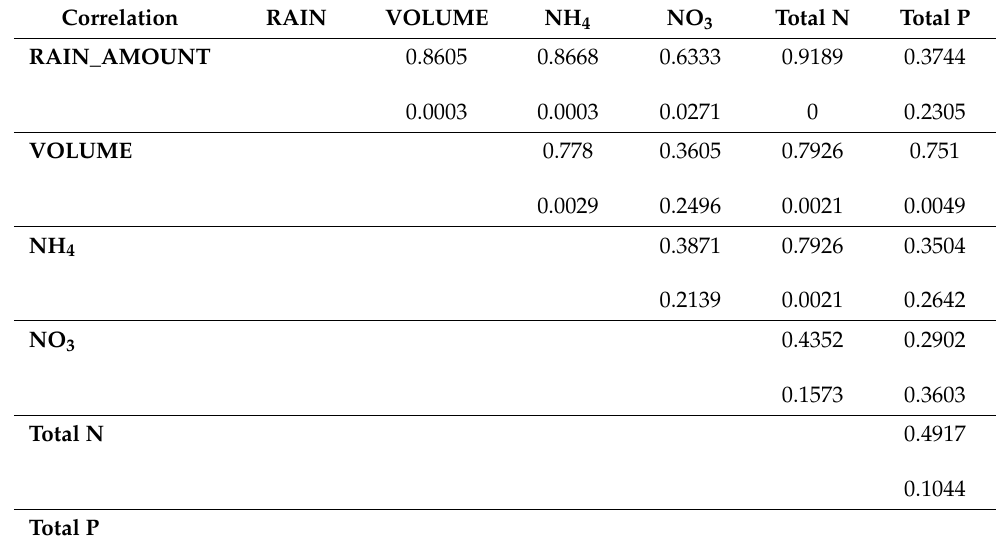
Table 6. Parameter correlations in pile